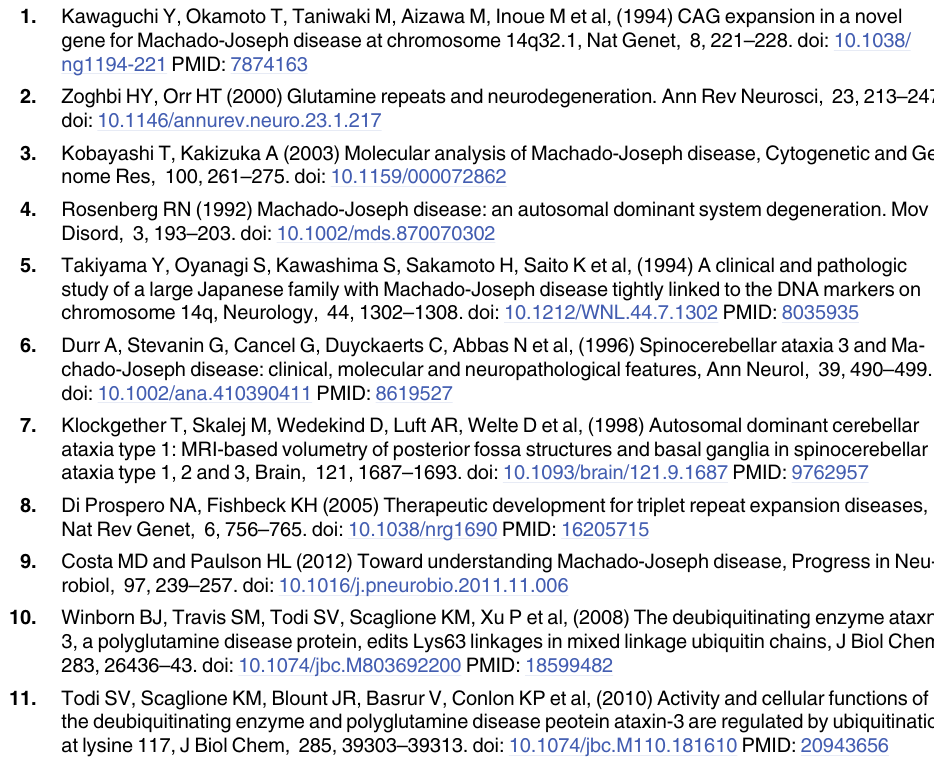
S19 Fig. Mutant ATXN3 activates pro-apoptotic pathway by activating c-Abl kinase pathway. (A) Caspase-3 activities in SH-SY5Y cells expressing ATXN3-Q28 and ATXN3- Q84, and expressing ATXN3-Q28 and ATXN3-Q84 in the presence of STI-571; caspase-3 ac- tivities are expressed as percentage change normalized to control. Data represent means ± SD; (n = 3; (cid:2)(cid:2)(cid:2) = p < 0.001). (B) Caspase-3 activities in SH-SY5Y cells transfected with PNKP- or control-siRNA , and in SH-SY5Y cells pre-treated with the c-Abl inhibitor STI-571 and trans- fected with PNKP-siRNA ; caspase-3 activities are expressed as percentage change normalized to control. Data represent means ± SD (n = 3; (cid:2)(cid:2)(cid:2) = p <